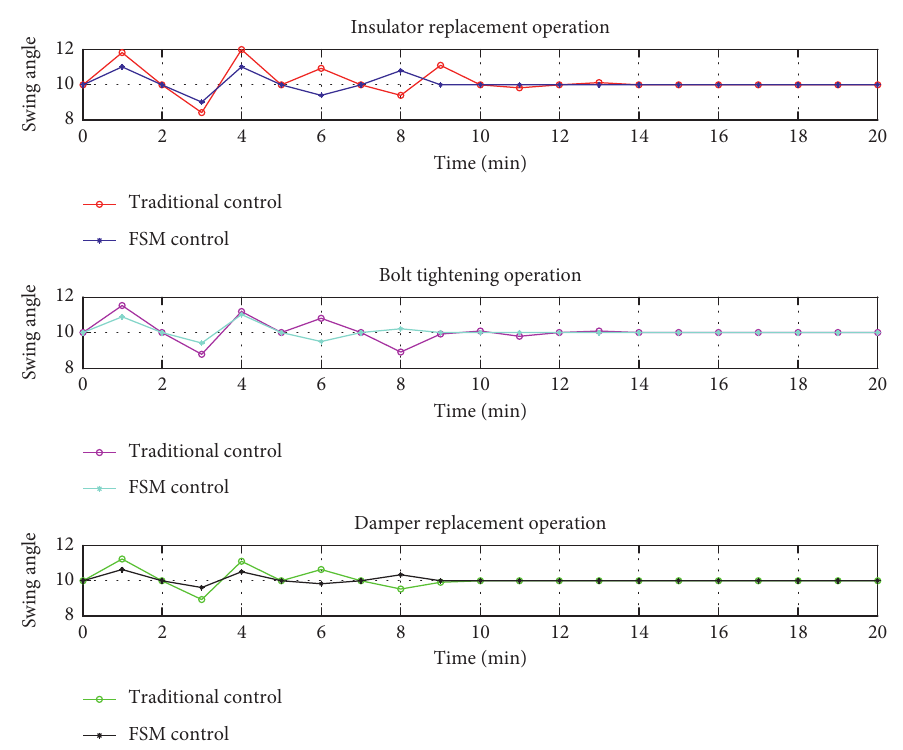
Figure 13: Robot performance under different